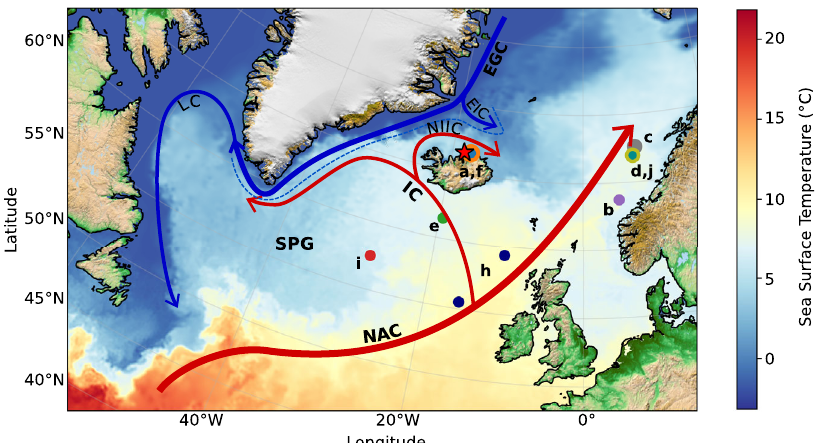
Fig. 1 | Bivalve derived proxy records location and regional ocean circulation. Redarrowsrepresenttherelativelywarmandsaltywaterscarriednorthwardsbythe North Atlantic Current (NAC), westward as the Irminger Current (IC), and clockwise around Iceland as the North Icelandic Irminger Current (NIIC). Blue arrows corre- spond to relatively cool and fresh Arctic waters transported southward by the East Greenland Current (EGC) that diverts north of Iceland as the East Iceland Current (EIC) and southwest of Greenland as the Labrador Current (LC). The subpolar gyre (SPG) fl ows anticlockwise in the subpolar North Atlantic. The dashed blue line